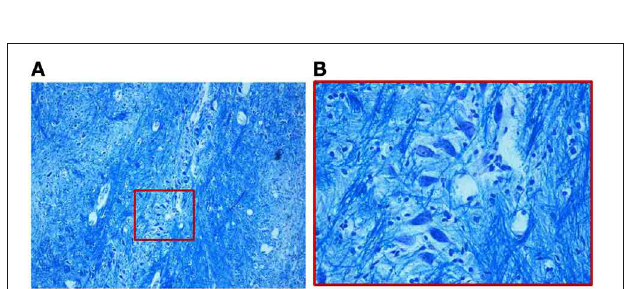
FIGURE 3 | (A) Organization of the MSO in a 2-month-old infant of the control group. The neurons, as shown in the magnified boxed area (B) , are fusiform with prevalently similar orientation. Klüver–Barrera stain. Magnification: (A) 10 × ; (B) 40 × .